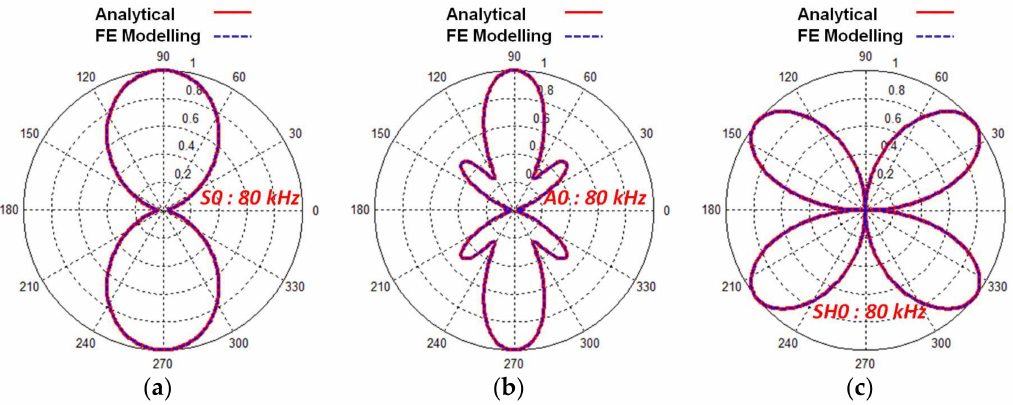
Figure 9. Normalized directivity characteristics of the S0 ( a ), A0 ( b ) and SH0 ( c ) guided wave modes at 80 kHz, 5-period excitation signal for the P1-type MFC transducer glued on 2 mm Al alloy plate obtained by analytical and FE